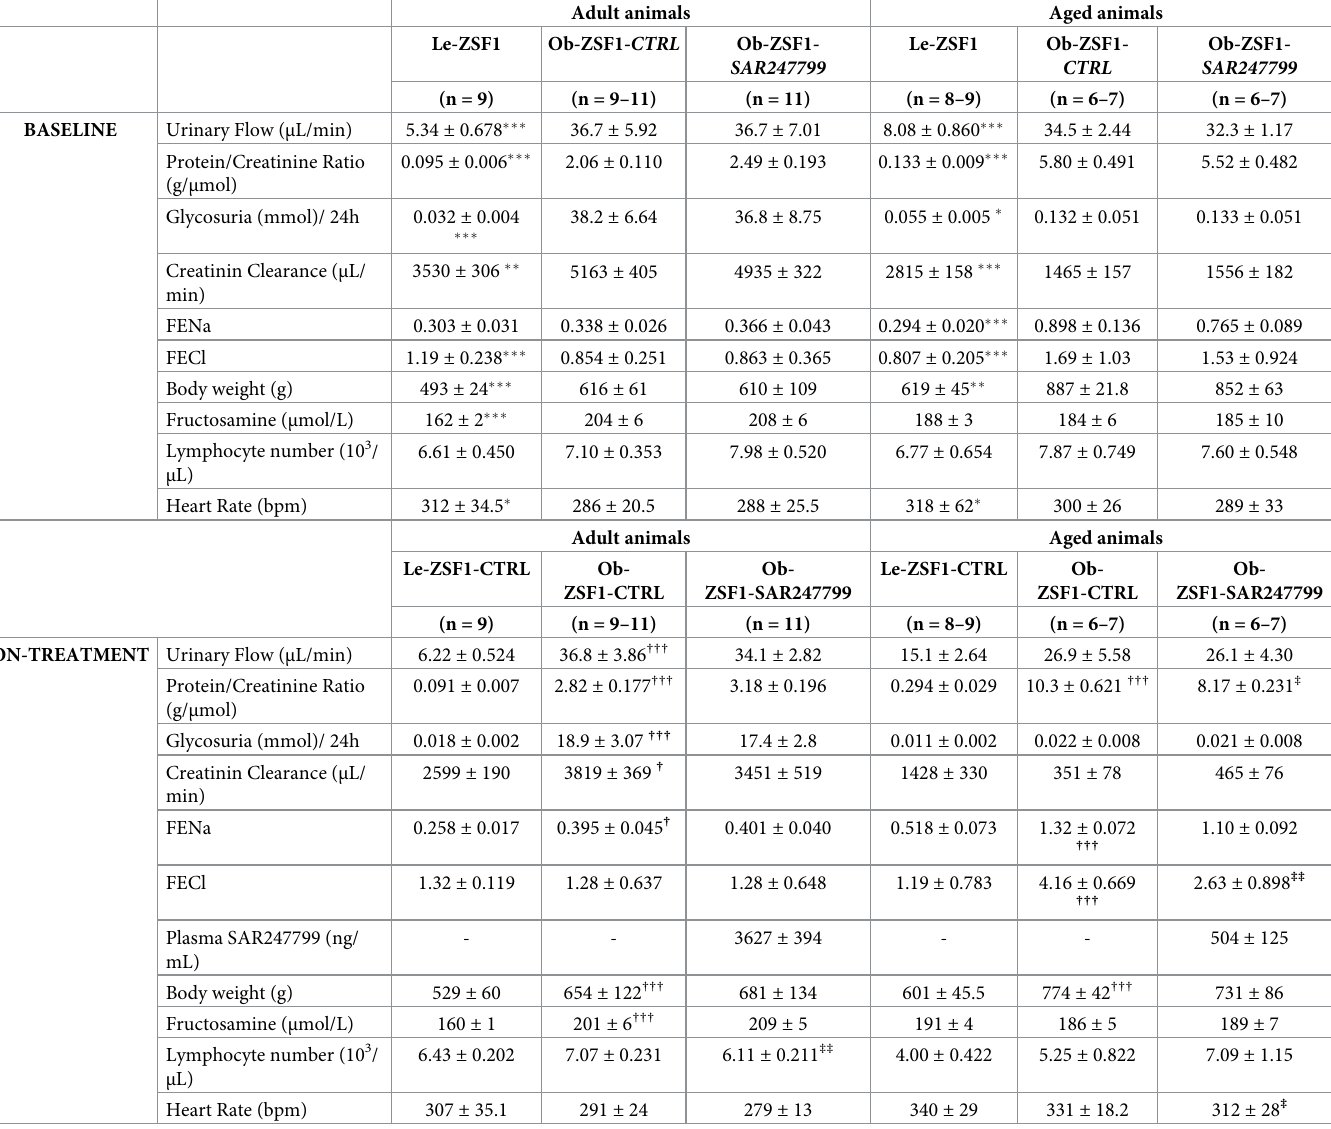
Table 1. Renal function and physiological parameters at baseline and after 4 weeks of